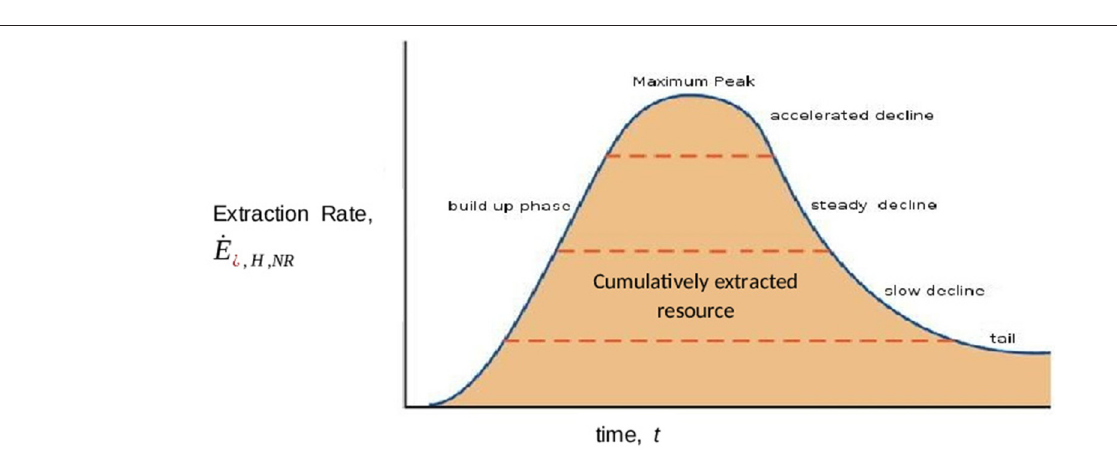
FIGURE 4 | Qualitative representation of the time evolution of ˙ E in , H in a closed system.